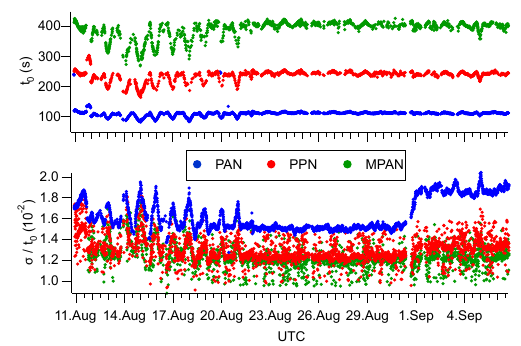
Figure A1. Stability of the PAN-GC retention times (top) and rel- ative peak widths (bottom). The temperature inside the trailer was considerably more stable after 21 August, after an auxiliary air con- ditioning unit was installed.